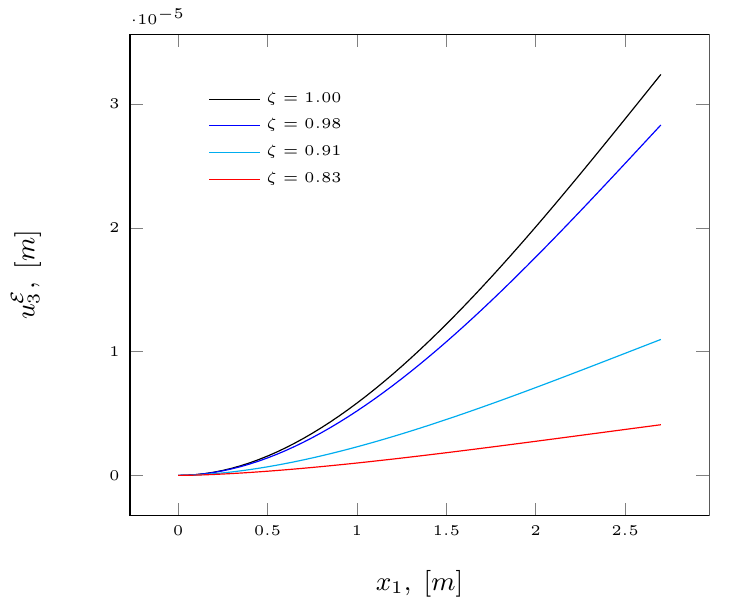
Figure 4. Lateral displacement on a cantilever beam with a variable length scale for a homogeneous beam ( ζ = 1) and fractal beams with: ζ = 0.98, ζ = 0.91 and ζ = 0.83. The length of the beam is L ζ ξ 1 − ζ 0